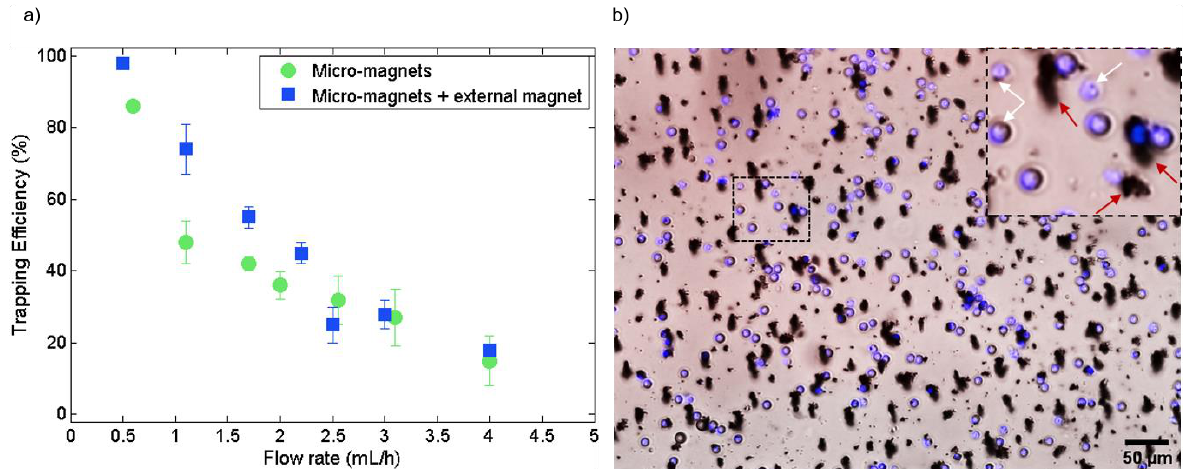
Figure 6. ( a ) Magnetic trapping efficiency of 12-µm SPMBs on the micro-magnets as a function of the flow rate, with or without the external magnet. ( b ) Composite microscope image showing trapped magnetically labeled WBCs (blue) in the microfluidic channel at 200 µL/h. All white blood cells are trapped on magnetic traps. What appears to be large traps are instead agglomerates of magnetic nanoparticles (red arrows in the inset). The inset highlights the trapping of white blood cells on less visible magnetic traps (white arrows).